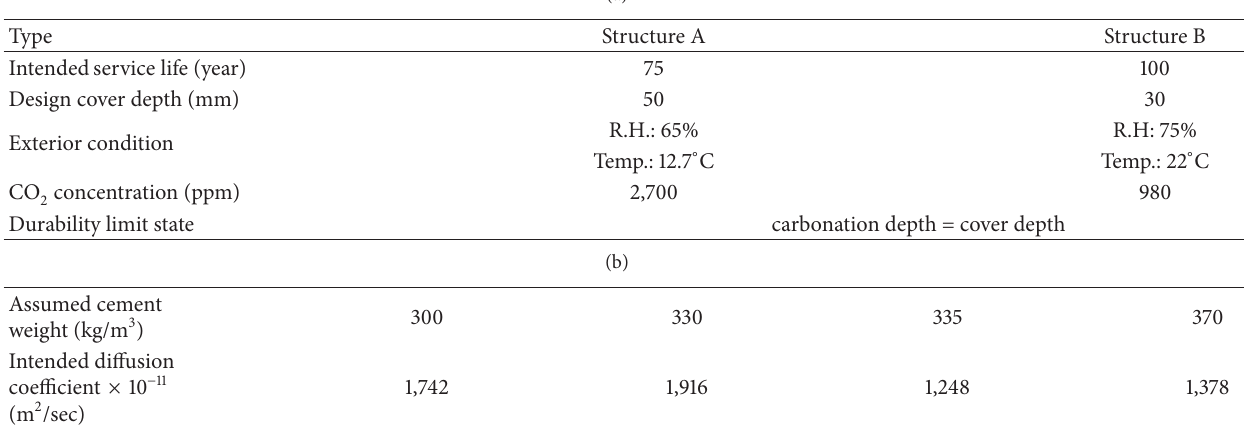
Table 8: Design parameters for carbonation design.